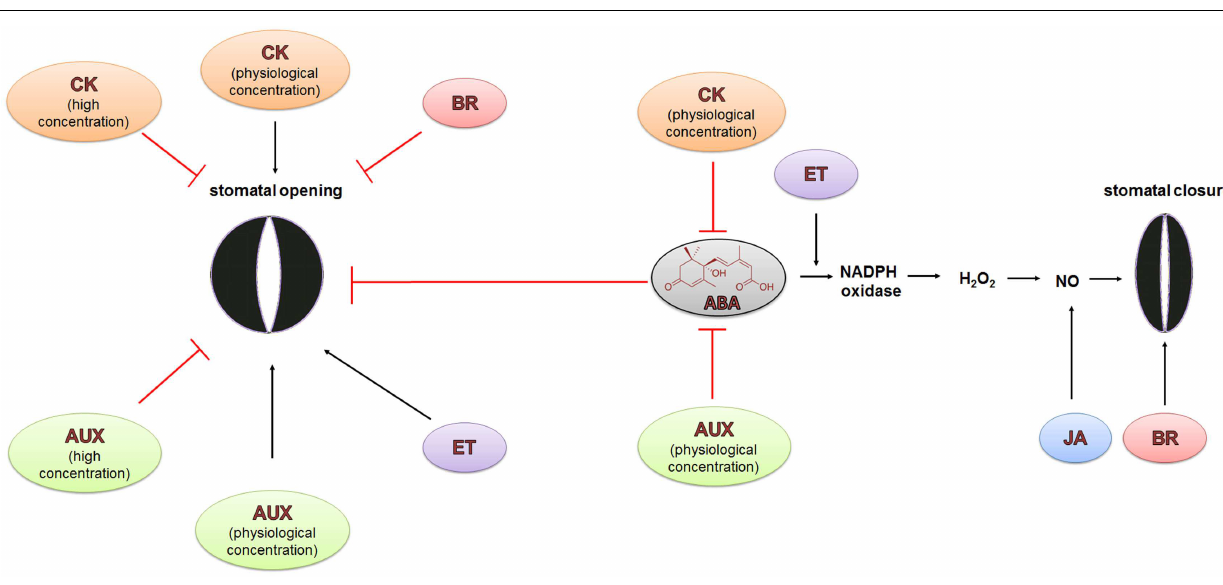
FIGURE 6 | Hormonal crosstalk in the regulation of stomatal closure and opening during water stress .The regulation of stomatal opening and closure is not only regulated by ABA, whose role is dominant, but also by other phytohormones. Jasmonates (JA) and brassinosteroids (BR) induce stomatal closure and inhibit stomatal opening under drought conditions,